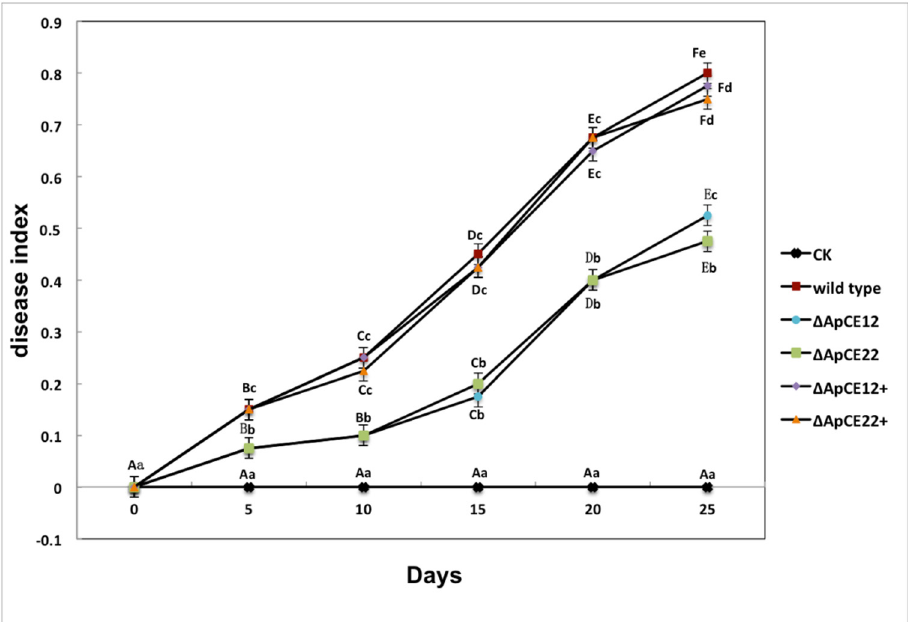
Figure 14. Dynamic changes in the disease index of B. pervariabilis × D. grandis infected by different strains. Note: CK, wild type, Δ ApCE12 , Δ ApCE22 , ApCE12 complementary strain, and ApCE22 complementary strain represent the changes in the disease index of B. pervariabilis × D. grandis inoculated with sterile deionized water, wild-type strain, ApCE12 deletion mutant, ApCE22 deletion mutant, ApCE12 complementary strain, and ApCE22 complementary A. phaeospermum, respectively. All assays were repeated three times; the data were analyzed using one-way ANOVA and Duncan’s range test in SPSS 16.0. Different lowercase letters indicate that the disease index of different strains in the same period is significantly different, and different capital letters indicate that the disease index of the same strain in different periods is significantly different ( p ≤